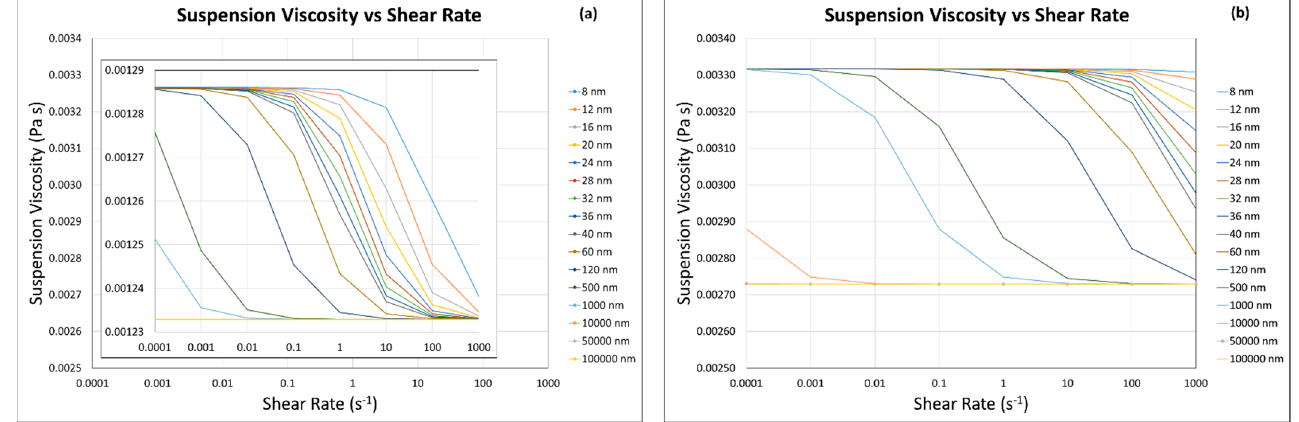
Figure 5. Viscosity of quartz particle suspension as a function of shear rate calculated by using our predictive model, at solid fraction ( a ) ϕ = 0.1 and ( b ) ϕ = 0.3. Note: the major y-axis of subfigure ( a ) is made for the purpose of comparison. Table 2. DLVO total potential energies between two quartz particles at different solid fractions and particle sizes for the same quartz particles with the same particle sizes.